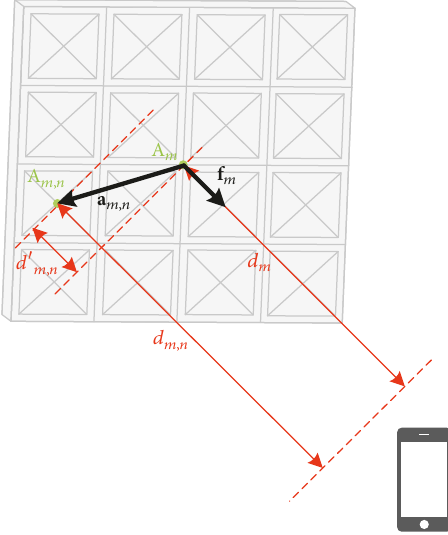
Figure 5: Inner product of two positioning